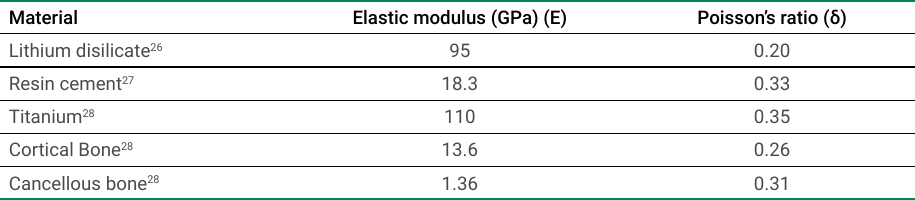
Table 1. Material properties used in finite element